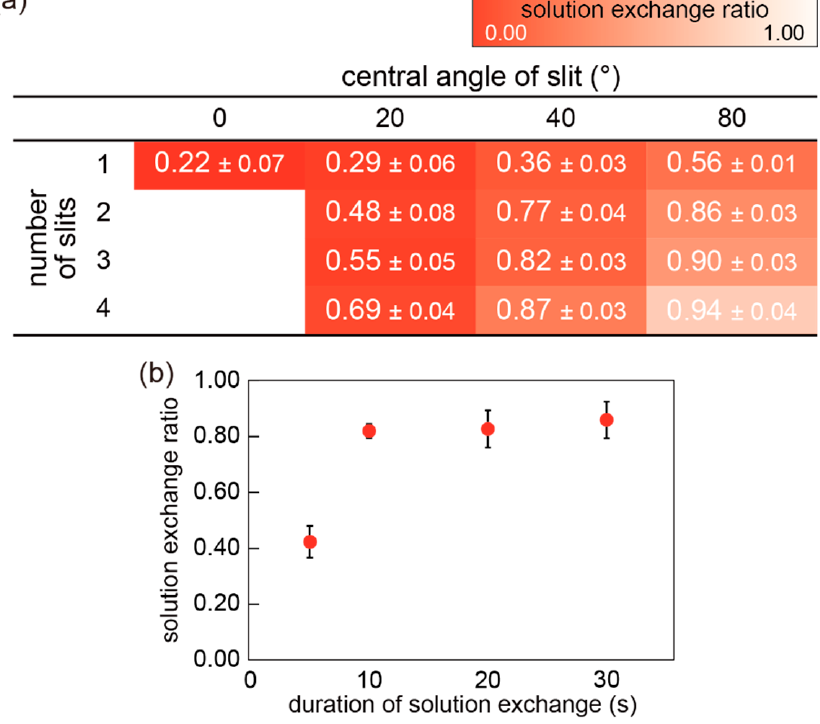
Figure 7. ( a ) Exchange ratio of the analyte concentration in mini-cup wells with different central angles and numbers of slits. The ratios and red colors in the table indicate the calcein concentration that remained in the well after the exchange (N = 3, mean ± SD). Concentration of calcein after the exchange was calculated from the fluorescence intensity using a calibration curve. ( b ) Exchange ratio vs. duration of the exchange procedure with the mini-cup well with 3 slits and a 40° angle (N = 3, error bar: SD). Each plot represents the single rinsing procedure with a defined duration.